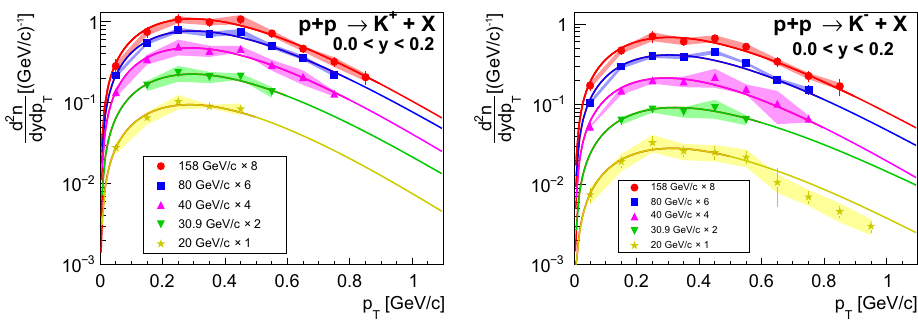
Fig. 32 Transverse momentum spectra of K + and K − mesons produced at y ≈ 0 in inelastic p + p interactions. Colored lines represent the fitted function (Eq.